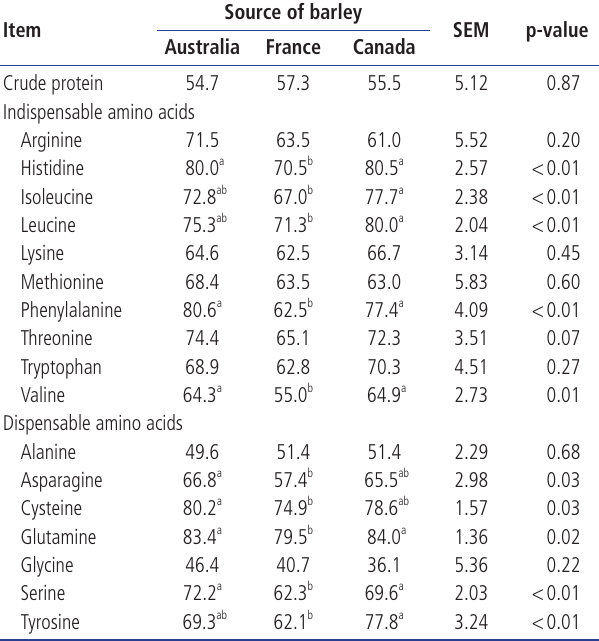
Table 6. The apparent ileal digestibility (%) of crude protein and amino acids in barleys obtained from different sources fed to growing pigs (Exp. 2) 1)